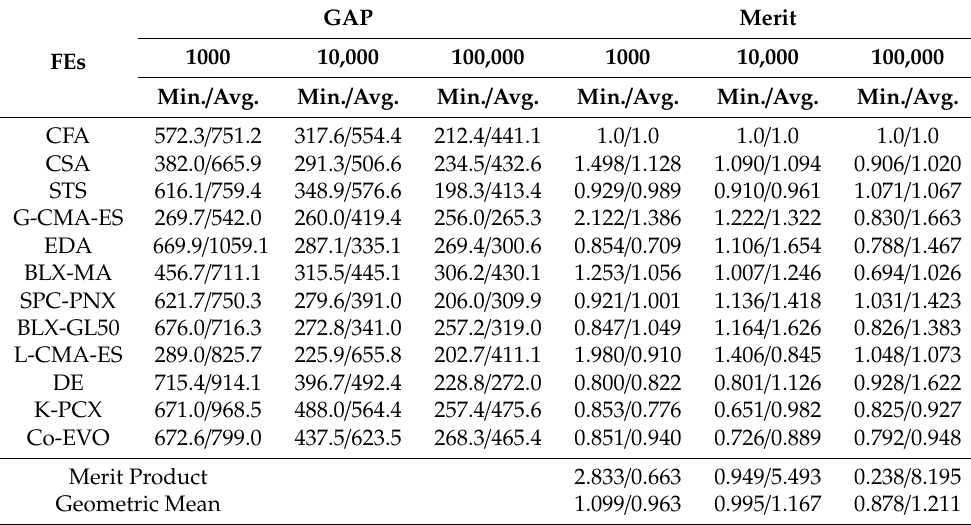
Table 10. Min. / Avg. GAP and Merit over the CEC dataset with n = 10. GAP FEs